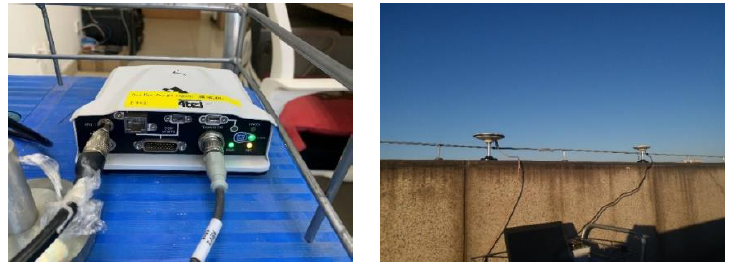
Figure 3. SPAN NovAtel ( left column ) is placed statically indoors and the antenna ( right column ) is set up outdoors to collect GNSS signals.